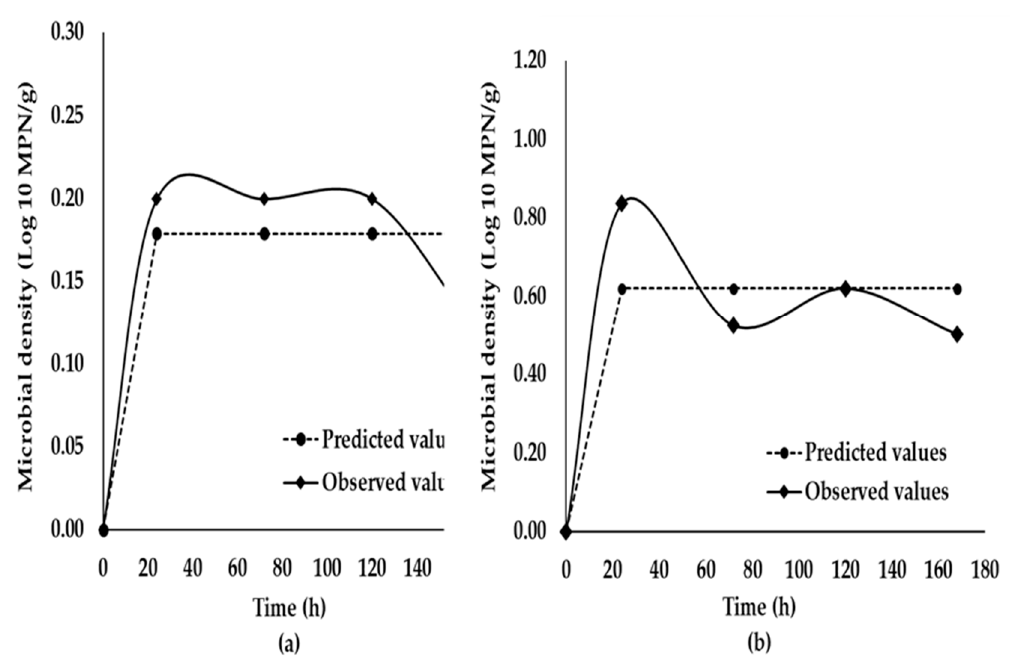
Figure 1. Comparison of the predicted and observed nonpathogenic tlh + ( a ) and pathogenic tlh +/ tdh + ( b ) growth in live oysters ( Crassostrea virginica ) during refrigerated storage at 7 ± 1 ◦ C for 180 h. Predicted growth values were fitted using Equation (1). Table 2. Parameter values using the modified Gompertz model for V. parahaemolyticus ( tlh + and tlh +/ tdh + ) growth at 7 ◦ C during 168 h in vivo (oyster) and 216 h in vitro. V. parahaemolyticus